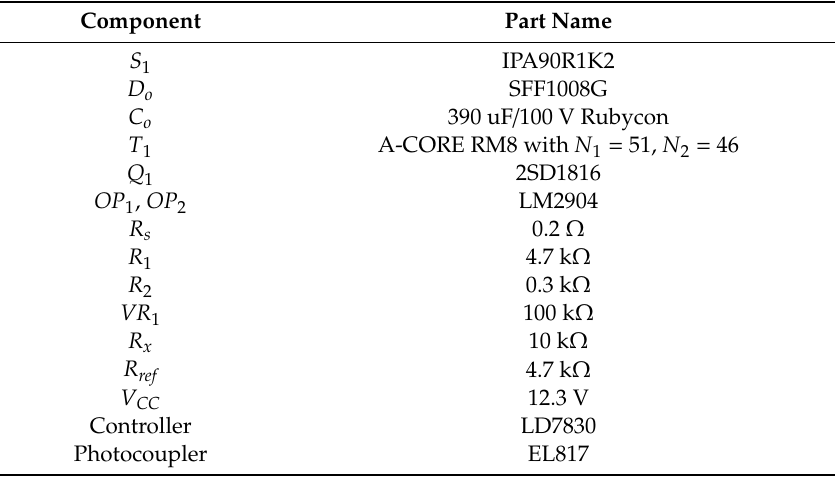
Table 3. Component